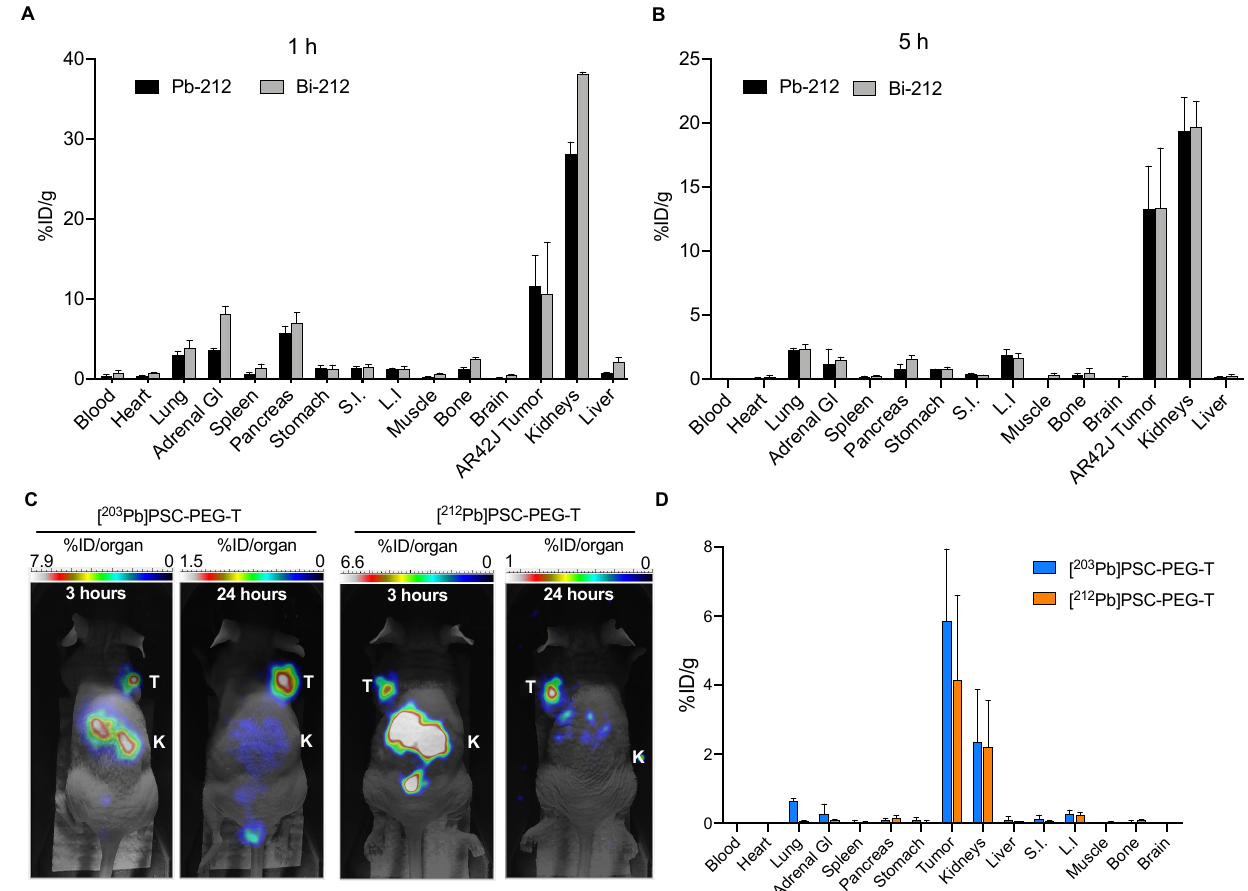
Figure 6. Biodistribution and micro-SPECT imaging in female athymic nude mice bearing AR42J xenograft. Biodistribution of [ 212 Pb]Pb-PSC-PEG-T and progeny [ 212 Bi]Bi-PSC-PEG-T at ( A ) 1 h and ( B ) 5 h post injection of 74 kBq [ 212 Pb]Pb-PSC-PEG-T via tail vein. [ 212 Pb]Pb-PSC-PEG-T and [ 212 Bi]Bi-PSC-PEG-T were co-injected when 212 Bi reached equilibrium with 212 Pb. Data presented as mean %ID/g ± SD (n = 2); SPECT imaging was generated at 3 and 24 h post injection of ( C ) 1.85 MBq [ 203 Pb]Pb-PSC-PEG-T and 3.7 MBq [ 212 Pb]Pb-PSC-PEG-T (T: tumor; K: kidneys; n = 2); ( D ) Post-im- aging biodistribution analysis was conducted to confirm the similar %ID/g of 203 Pb and 212 Pb in tu- mor and organs.